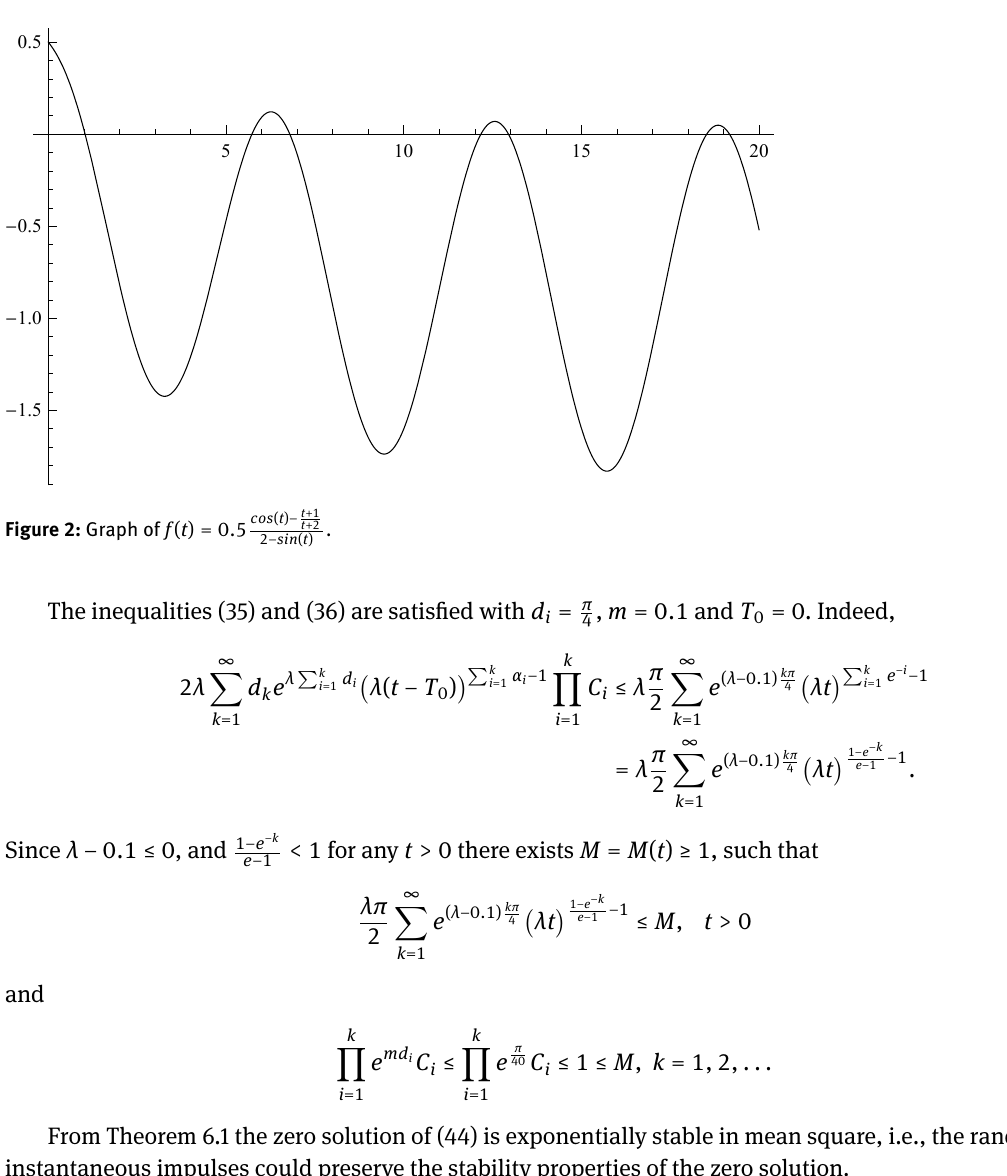
t +1 with x t +2 0 = 0.1, 0.5, 0.1 2− sin ( t )